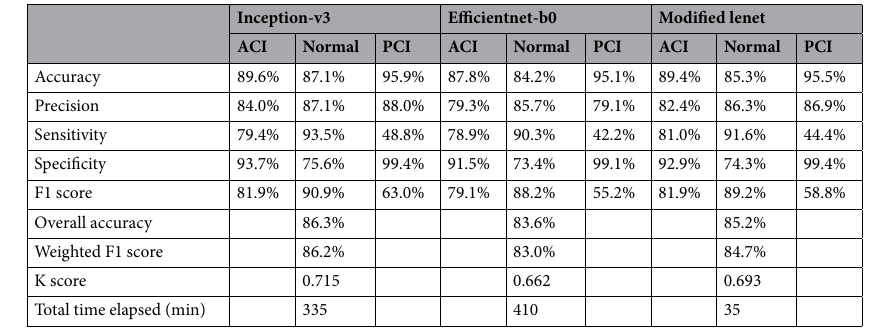
Table 6. Calculated metrics of all the models in classifying stroke vascular